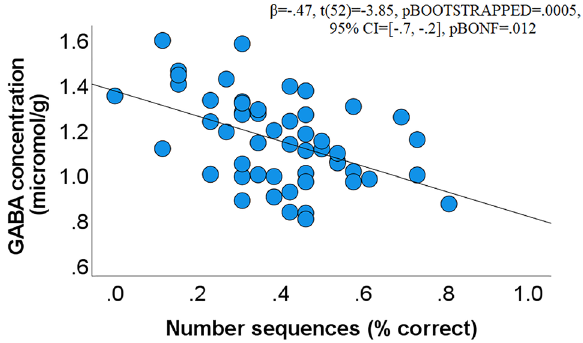
Figure 1. Scatterplot depicting a negative association between the accuracy in the number sequences subtest of the numerical aptitude test and the concentration of GABA within the left IPS (derived from Eq. 2).